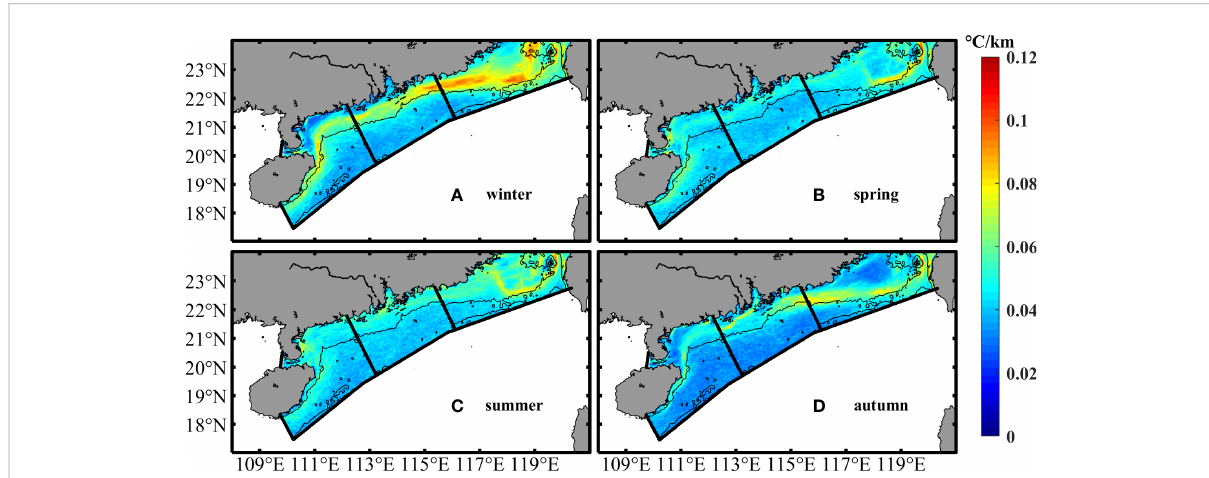
FIGURE 6 Mean SST gradient magnitude at frontal pixels averaged over 2002 − 2021 for (A) winter (January − March), (B) spring (April − June), (C) summer (July − September), and (D) autumn (October − December).The black lines are the 50-m and 200-m